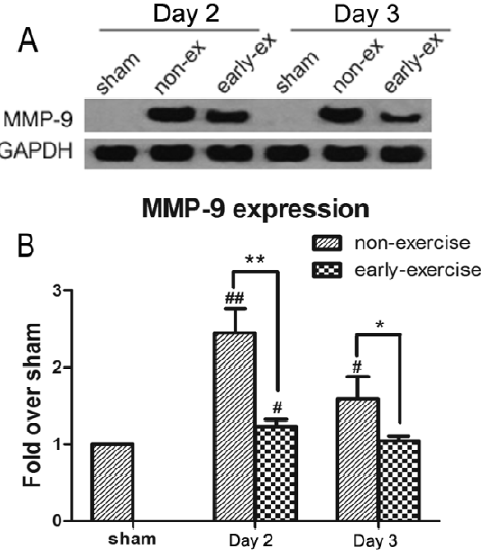
Figure 5. Effect of early exercise on the expression of MMP-9 protein following focal cerebral ischemia. ( A ) Representative bands of MMP-9 protein expression in the ipsilateral cortex following MCAO detected by Western blotting; ( B ) Quantification of the optical density of the MMP-9 band, normalized to GAPDH. Early exercise significantly inhibited the upregulation of MMP-9 expression that occurred after ischemic brain injury. * p < 0.05 and ** p < 0.01, compared with the non-exercise group; #, p < 0.05 and ##, p < 0.01, compared with the sham group. n =